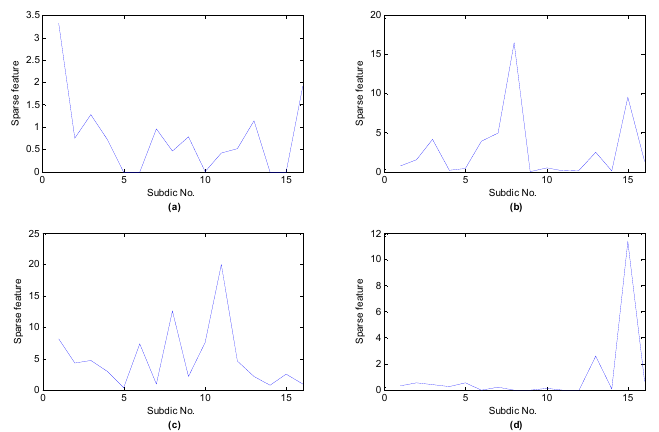
Figure 6. Shift invariant sparse feature of a test sample with respect to different running statuses: ( a ) normal; ( b ) inner race fault; ( c ) rolling element fault; ( d ) outer race fault.